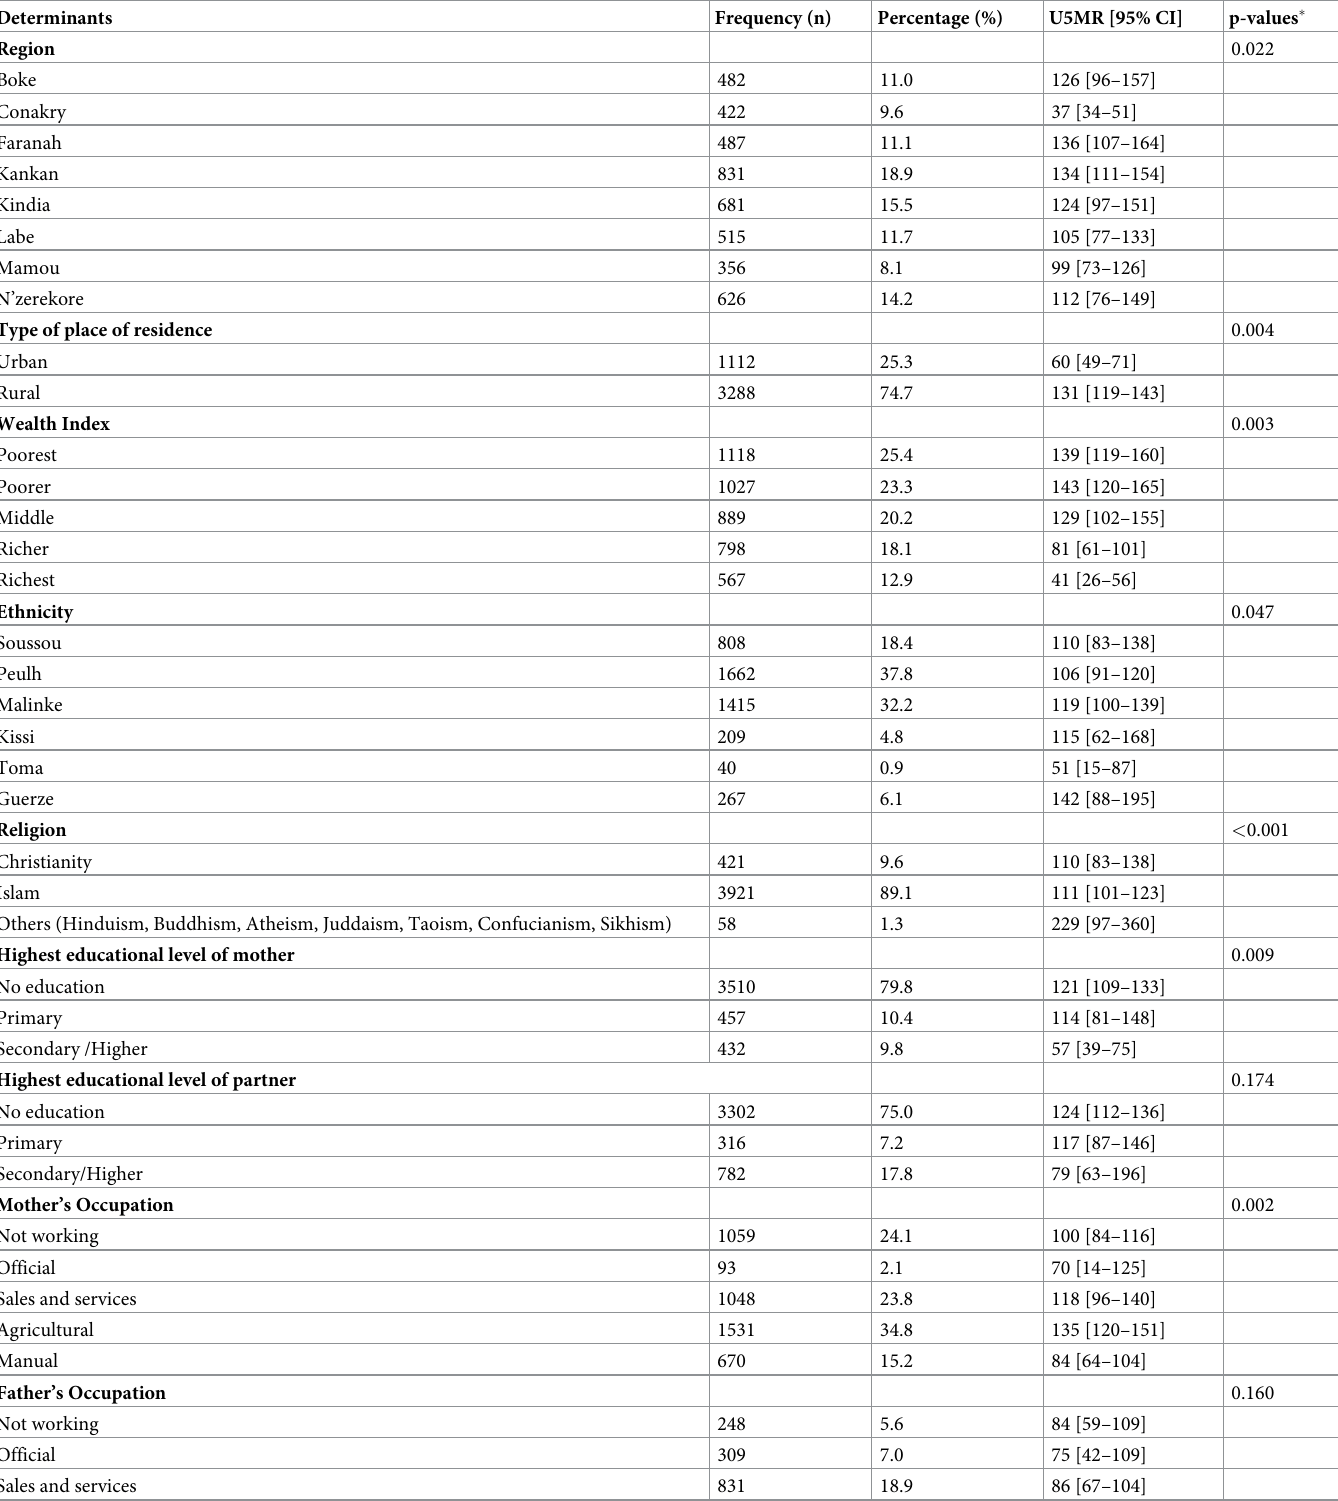
Table 1. Under-five mortality rate (per 1,000 live births) and unadjusted odds ratio by explanatory variables (n = 4400,